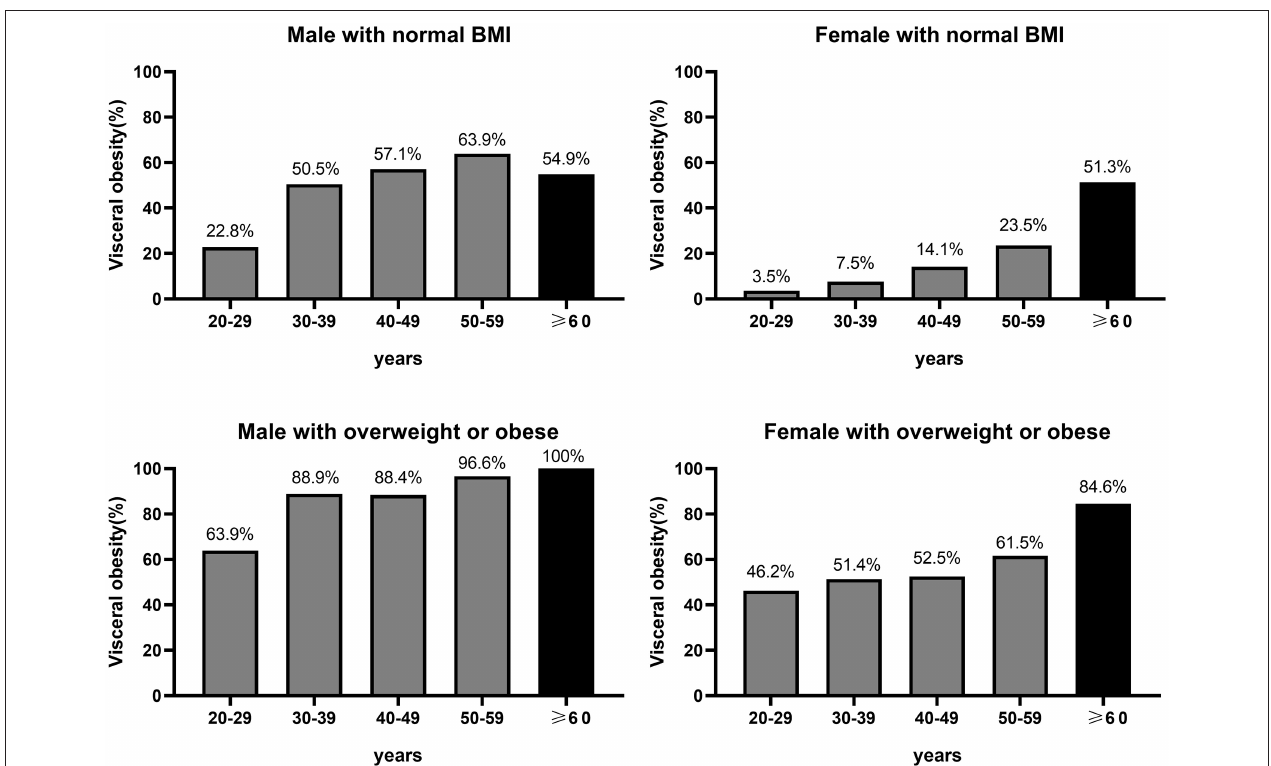
FIGURE 4 | Proportion of visceral adiposity in different age strata in people with different